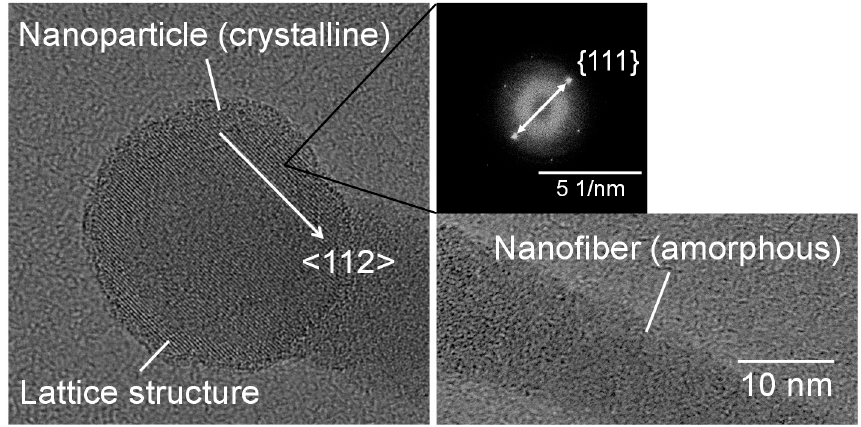
Figure 4. TEM images of a nanoparticle connected to a nanofiber generated at a gas pressure of 101 kPa.